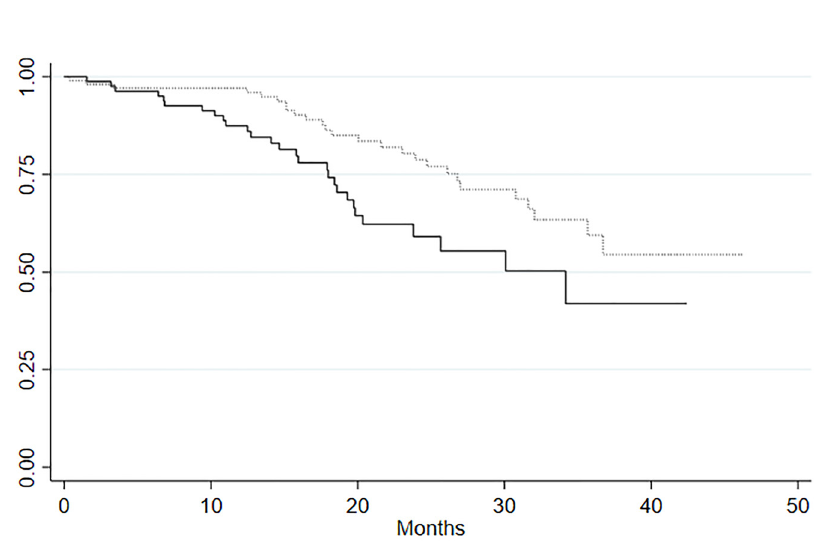
Figure 3: Survival by affection of omentum and spleen.